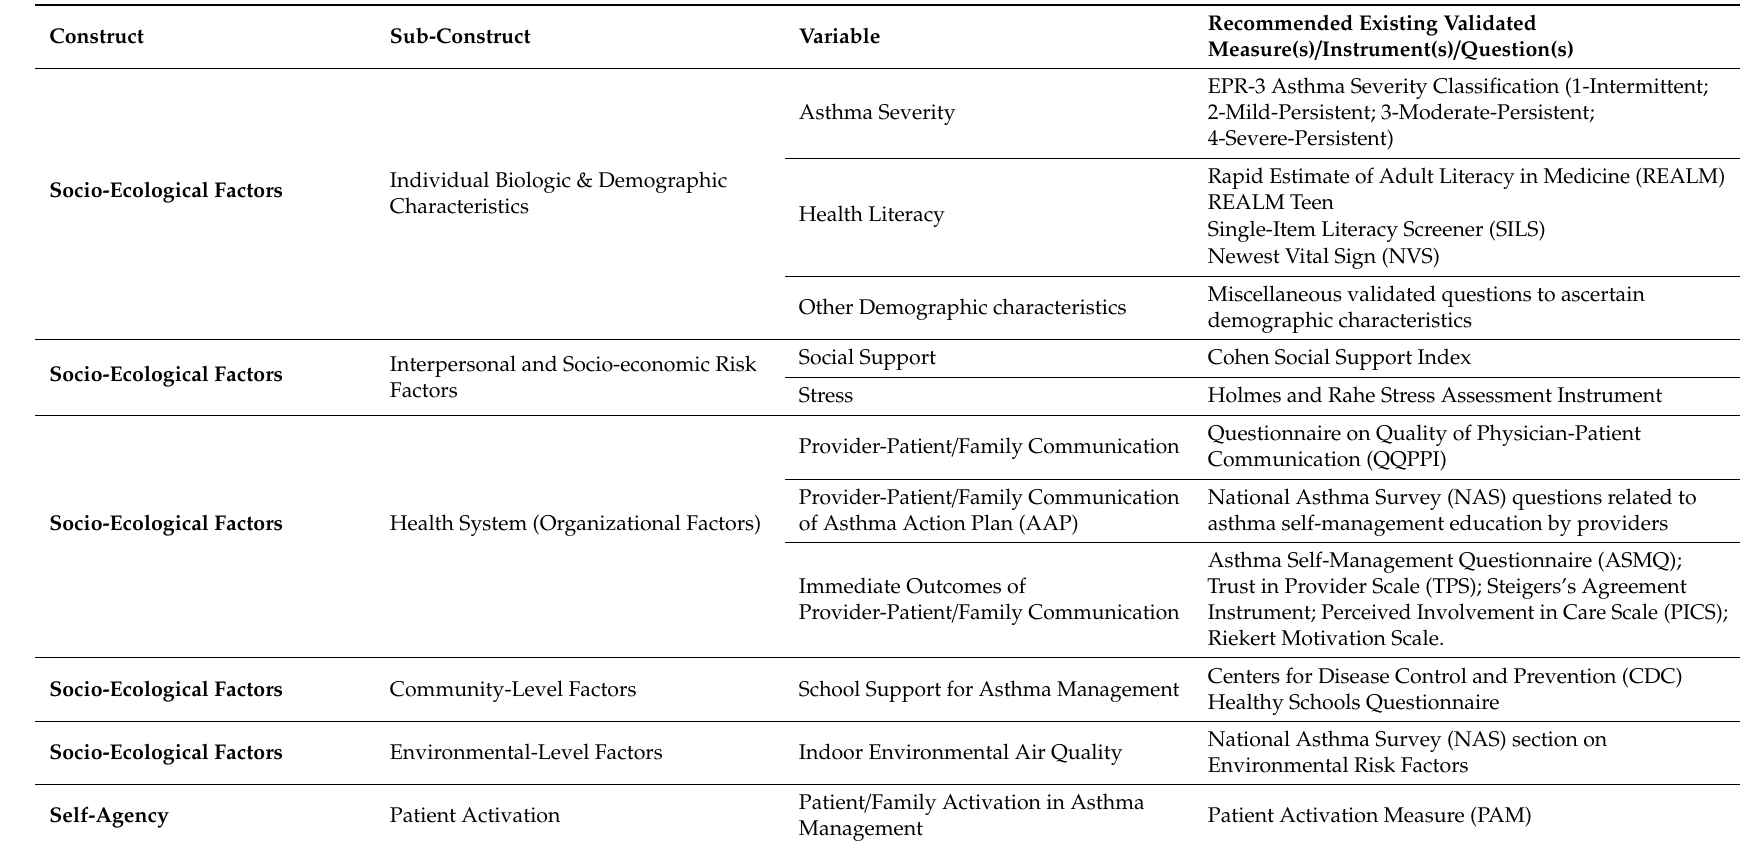
Table 2. Matrix Linking Key Constructs in Holistic Framework to Recommended Existing Validated